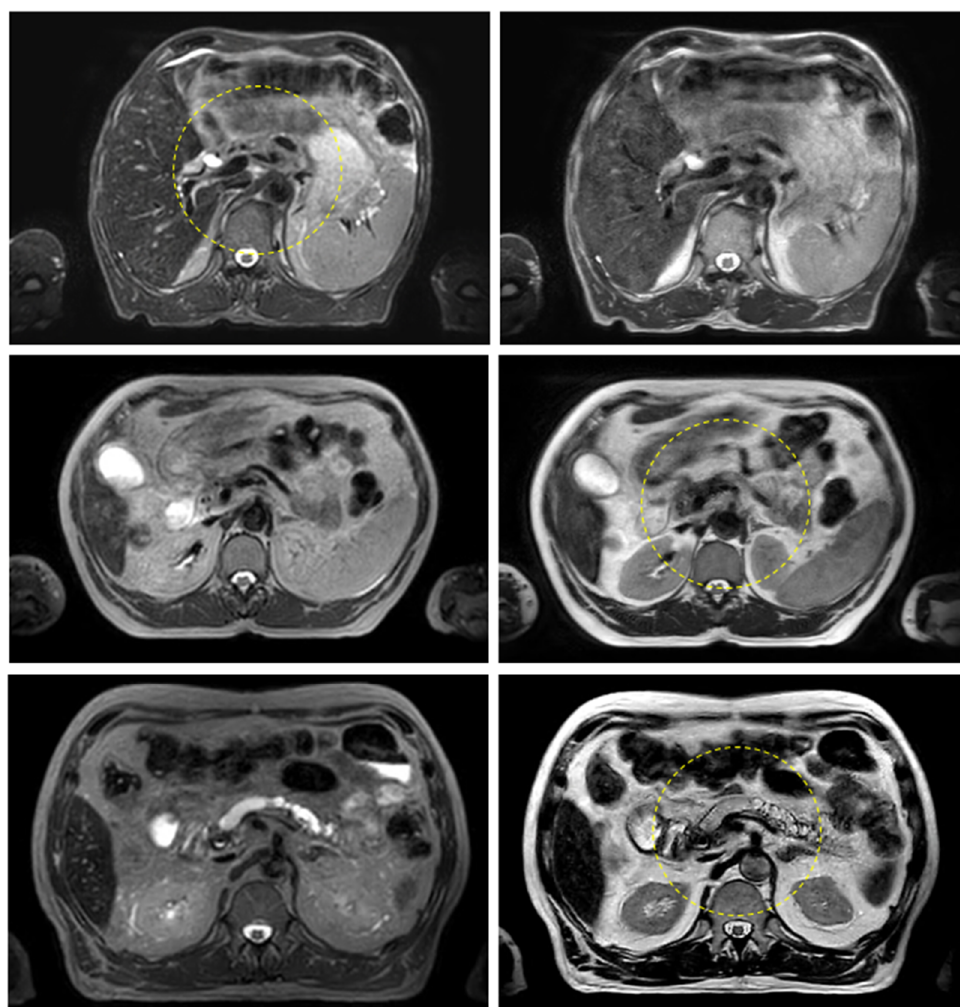
Figure 4. Pancreas examples highlighting the comparison between the T2w-Nav ( first column ) and T2w-Ave ( second column ) image sequences. The target location is identified by the yellow dashed circle. The planning data set was the T2w-Nav for the first case and T2w-Ave for the second and third case. The samples correspond to Patients 11, 14, and 16 as listed in Table 1.